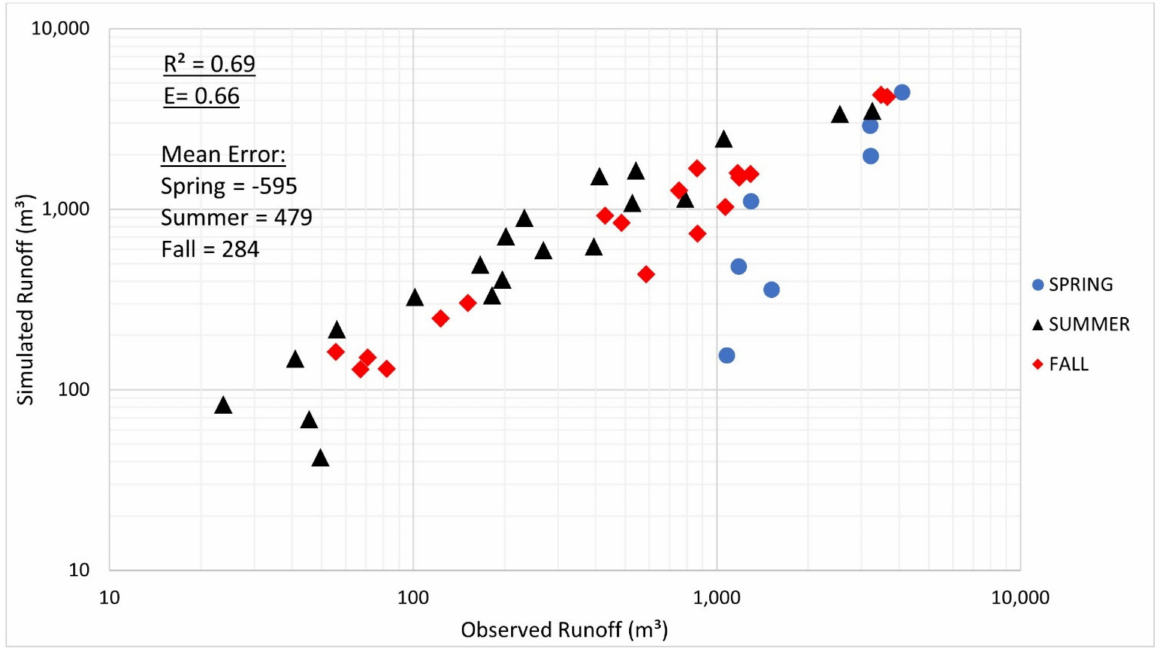
Figure 9. Comparison of the surface runoff simulated by the distributed CN–VSA method with the observed runoff for three